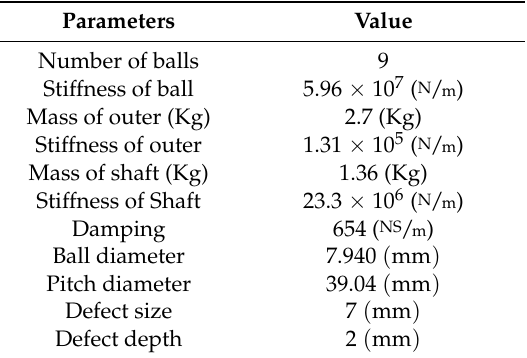
Table 1. Parameters of REB